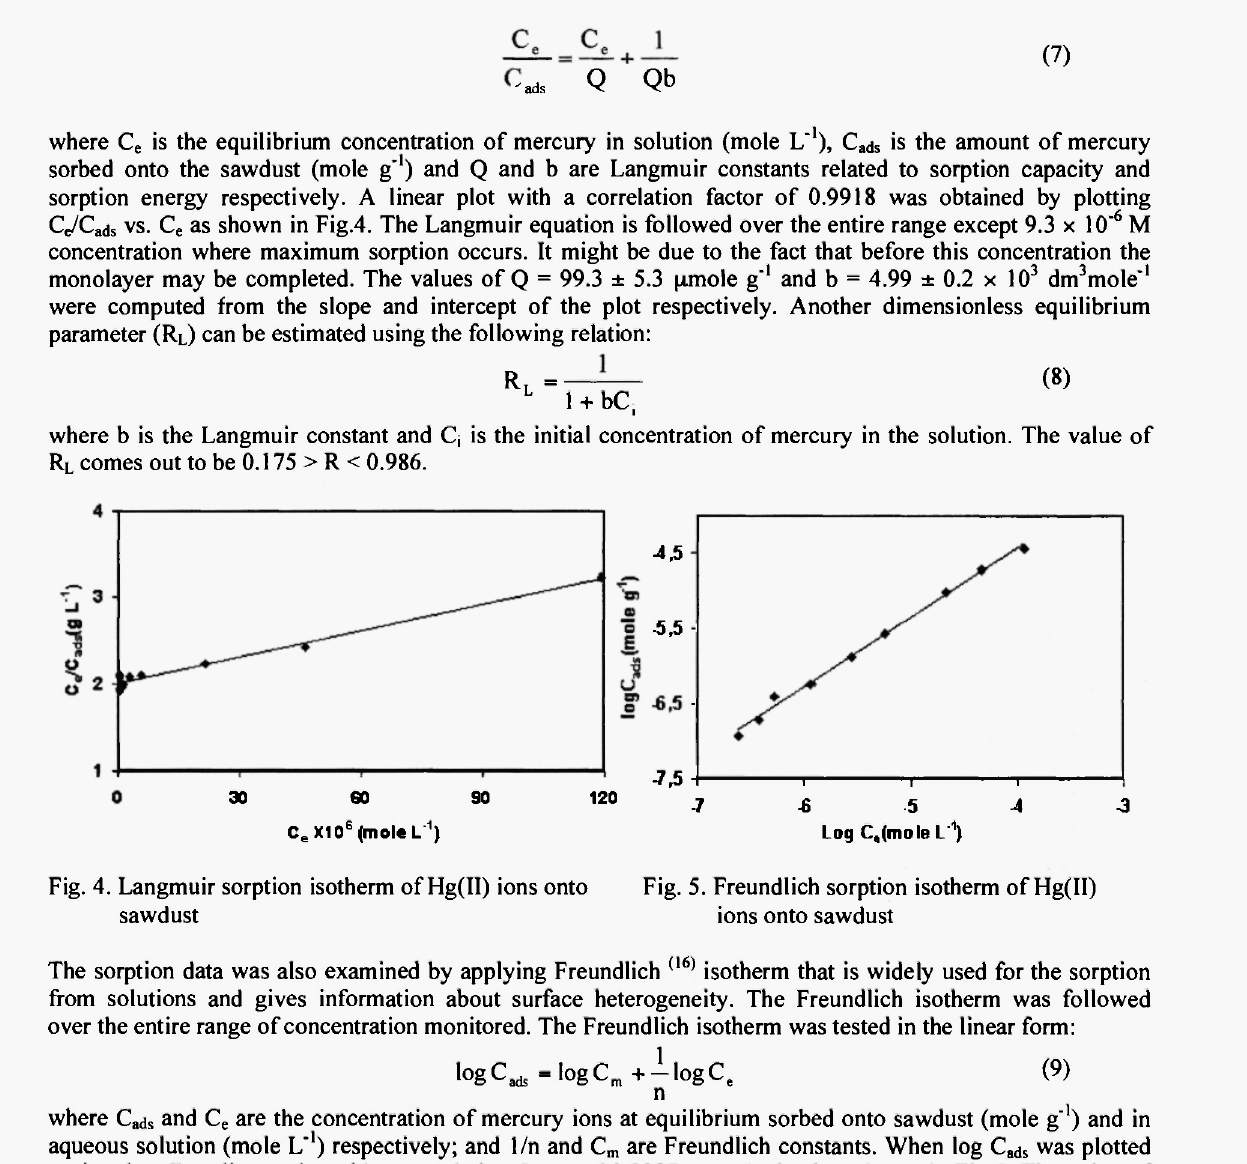
Fig. 4. Langmuir sorption isotherm of Hg(II) ions onto Fig. 5. Freundlich sorption isotherm of Hg(II) sawdust ions onto